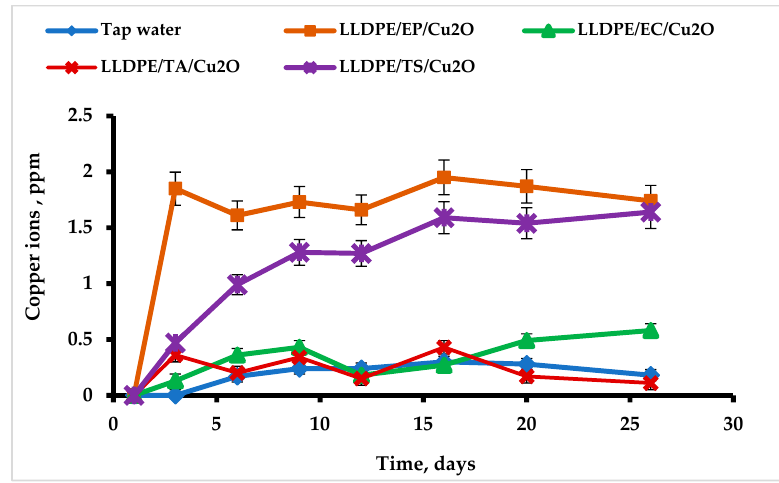
Figure 4. Testing the leaching of copper ions into tap water from LLDPE with Cu 2 ONPs attached to the surface using ethyl cyanoacrylate (EC), trimethoxyvinylsilane (TS), epoxy resin (EP), and thermal adhesion (TA). Control – tap water.